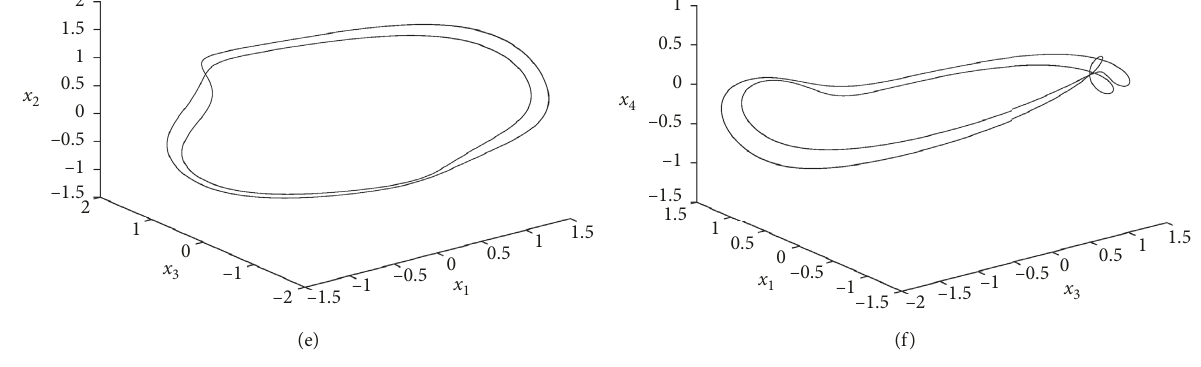
Figure 17: Periodic-2 motion occurs when b